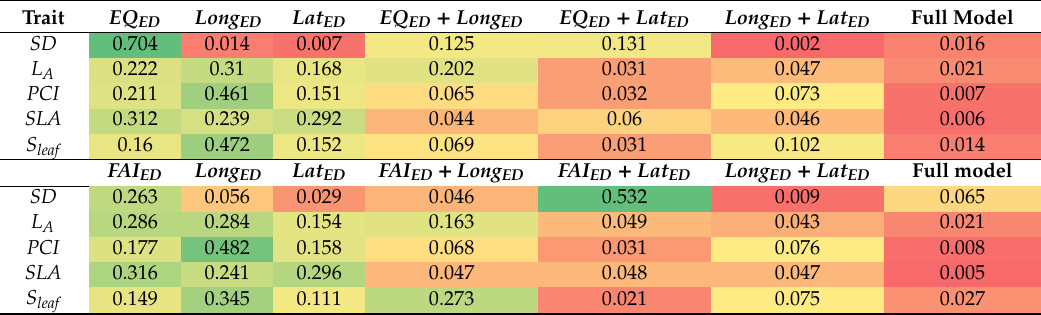
Table A2. AICc based variable weights of mixed models. Green to red spectrum represents the explanatory power of individual parameters and their combinations. Full model consists of all three parameters: aridity (expressed as the EQ and FAI ), longitude and latitude.